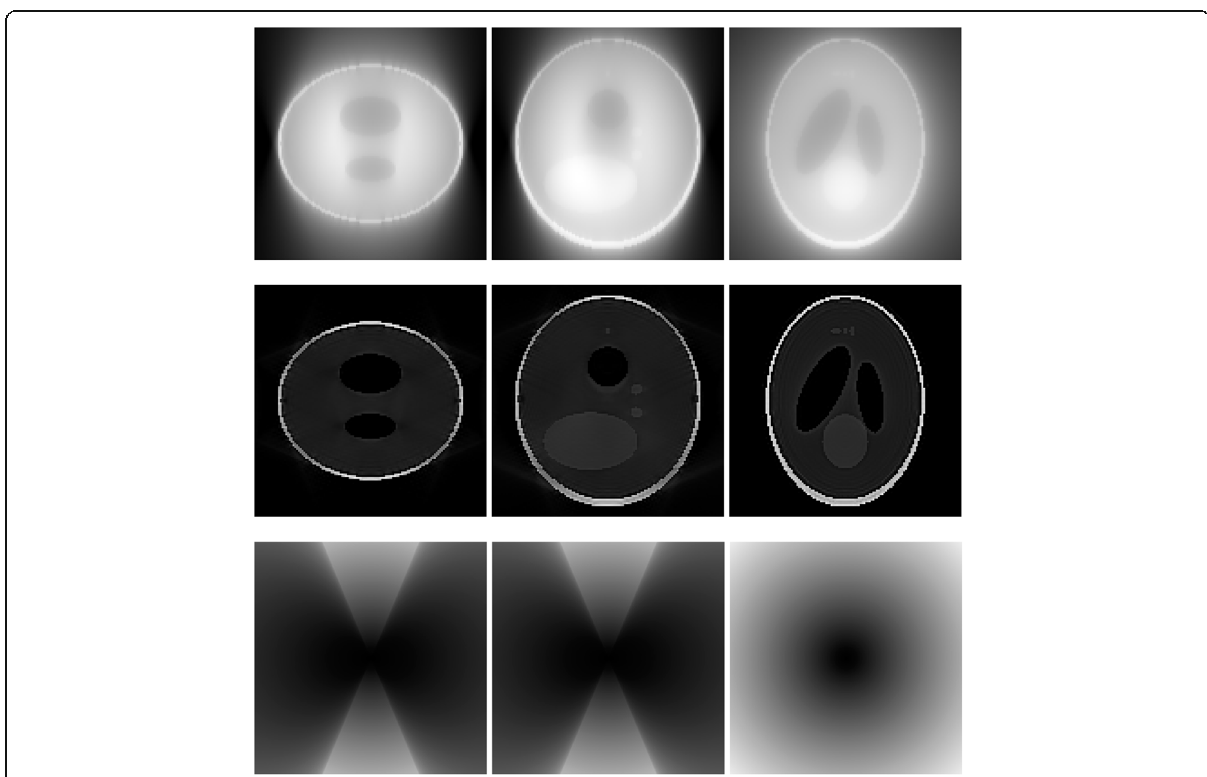
Fig. 5 Image reconstruction using proposed algorithm for the case of ψ = π /8 and σ = 100. Row 1 : TOF backprojection. Row 2 : Final reconstruction. Row 3 : Tomographic filter H . Three central orthogonal cuts are shown for each